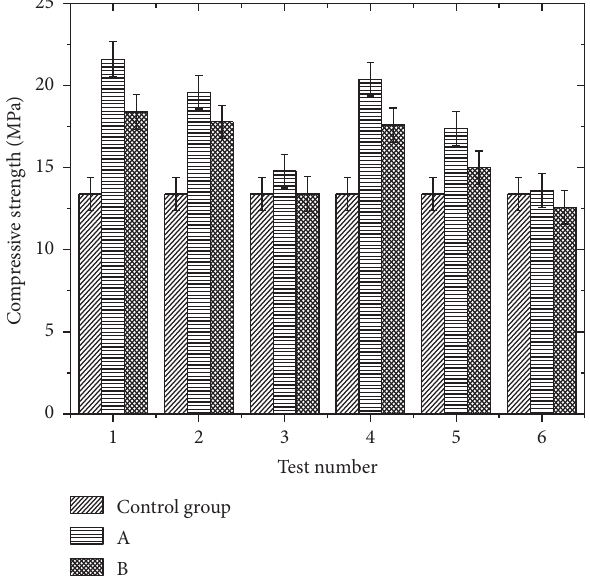
Figure 2: Compressive strength of permeable concrete.Note: A- 1 ∼ A-6: permeable concrete specimens with unmodified diatomite and zeolite powder in different dosages. B-1 ∼ B-6: permeable concrete specimen with modified diatomite and zeolite powder in different